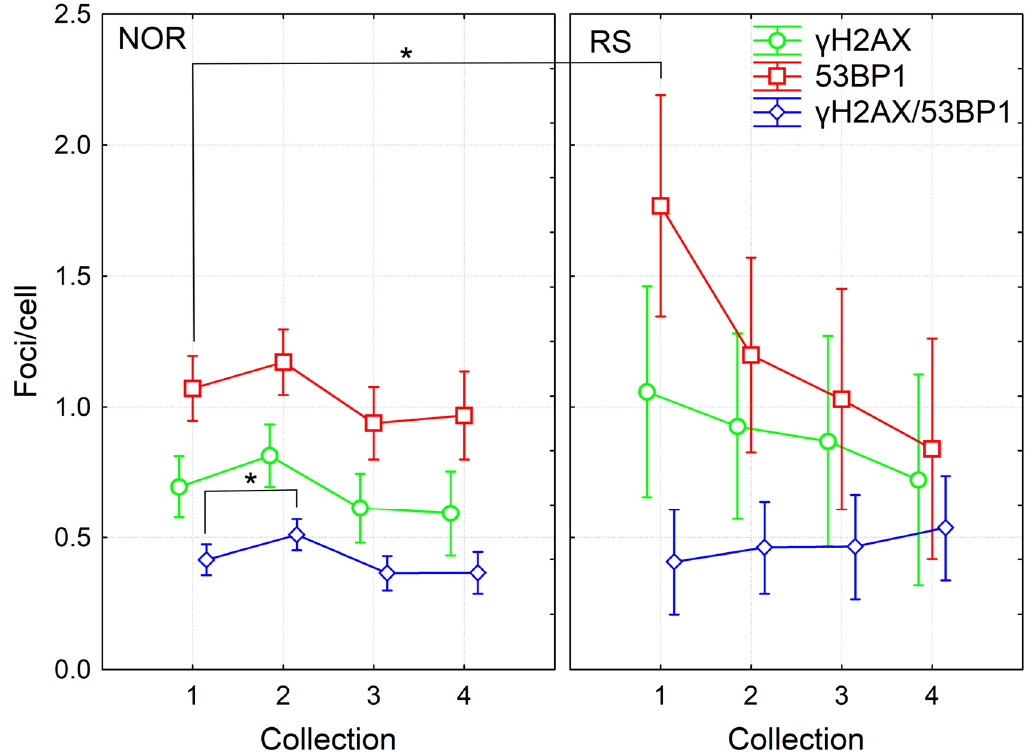
Figure 1. DNA repair γ H2AX /53BP1 foci in PBL from BC patients collected before (1), 24 h after 4th fraction (2) and after RT (one month (3), one year (4)). The mean numbers from 52 NOR (G0-G1 acute skin toxicity) and 5 RS (G2 acute skin toxicity) patients along with 95% confidence interval are shown. p -values are indicated by asterisk (* p ≤ 0.05).